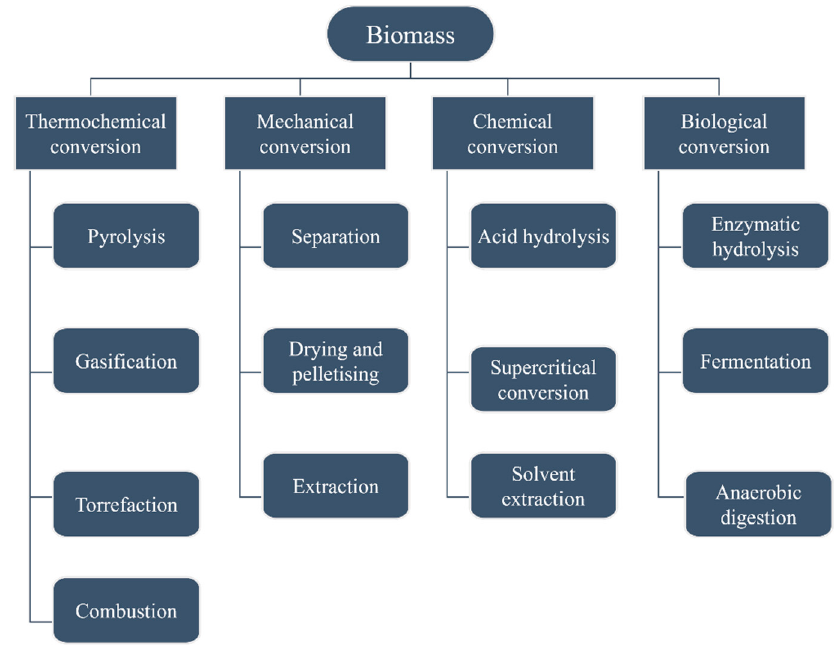
Figure 2. Schematic structure of biomass conversion processes (based on [71])